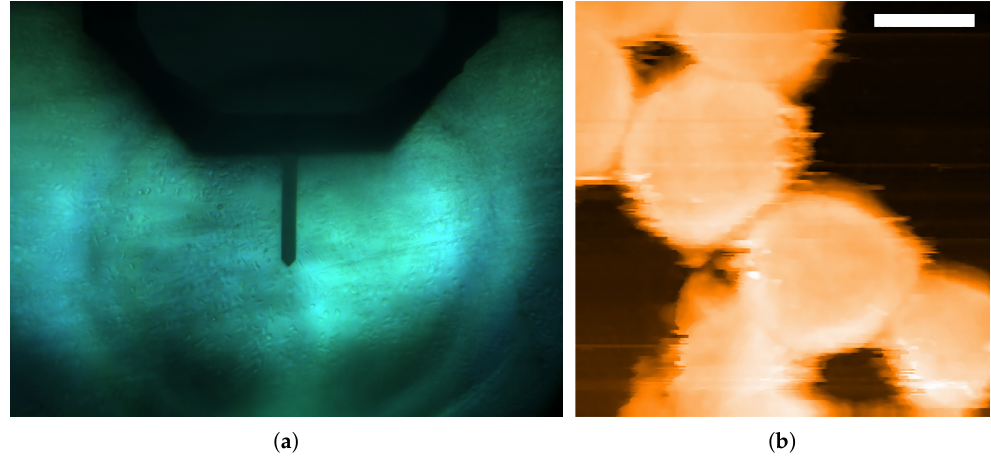
Figure 4. HKE-293 cells in PBS environment: ( a ) The experimental environment for the central indentation of HEK-293 cells ( b ) HEK-293 cells imaged by the AFM, Scale bar: 10µm.